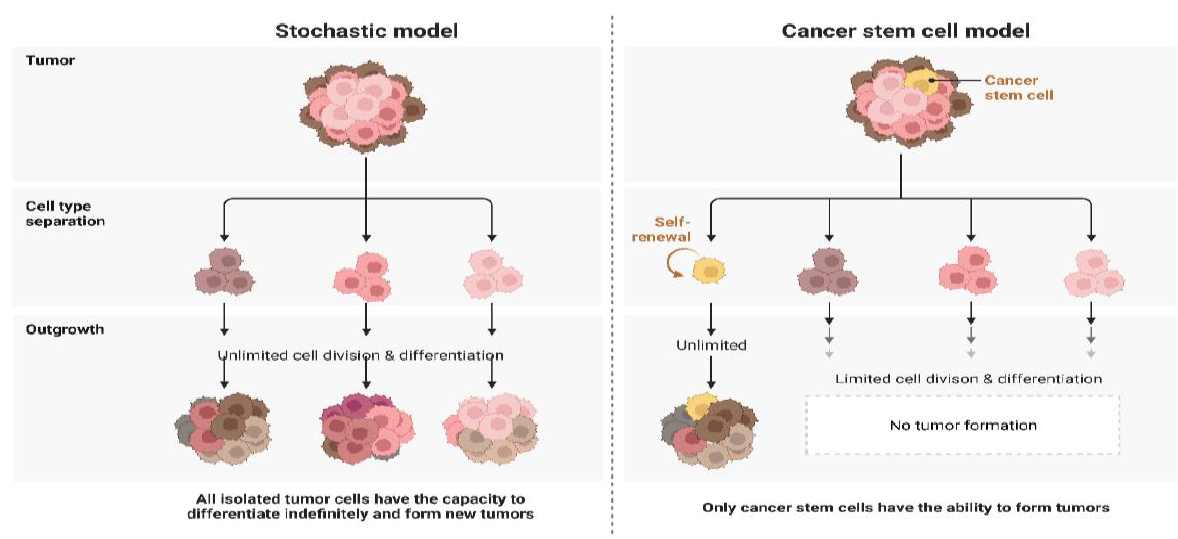
Figure 1. Schematic representation of the stochastic and CSC models of carcinogenesis.